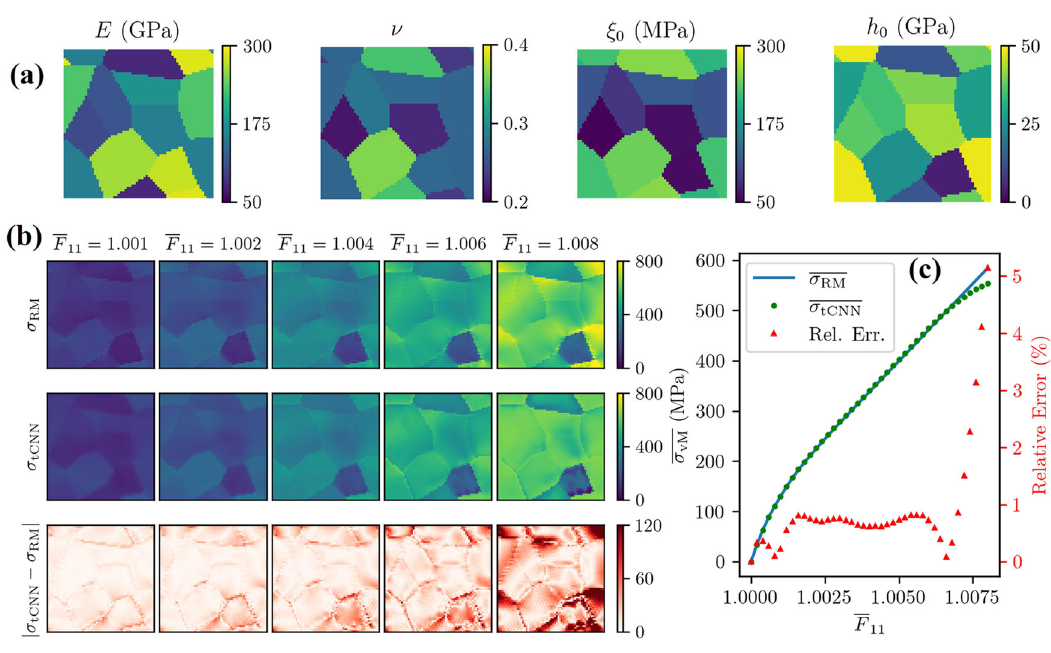
Fig. 8 Extension histories test microstructure subject to uniaxial extension along the horizontal axis. a Young ’ s modulus E , Poisson ’ s ratio ν , initial fl ow resistance ξ 0 , linear isotropic hardening modulus h 0 . b Results for different F 11 . c σ RM (blue curve), σ tCNN (green points), and relative error (red triangles) given by 100 ð σ tCNN (cid:3) σ RM Þ = σ RM versus F 11 .